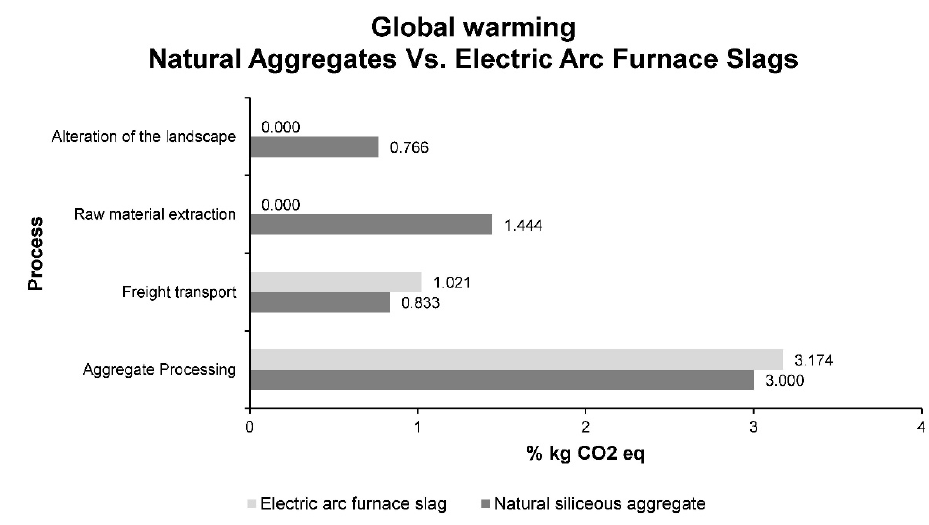
Figure 5. Global warming emissions in kilograms of CO 2 equivalent for electric arc furnace slags and natural siliceous aggregates.